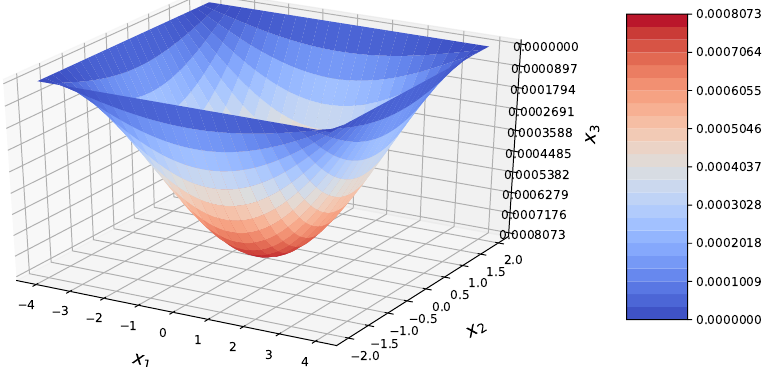
Figure 13. Three-dimensional plot of the deflection of simply supported rectangular plate.